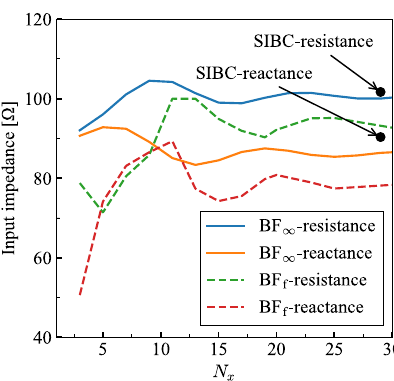
Fig. 6. Input impedance of dipole antenna vs. N x at resonant frequency 15GHz.